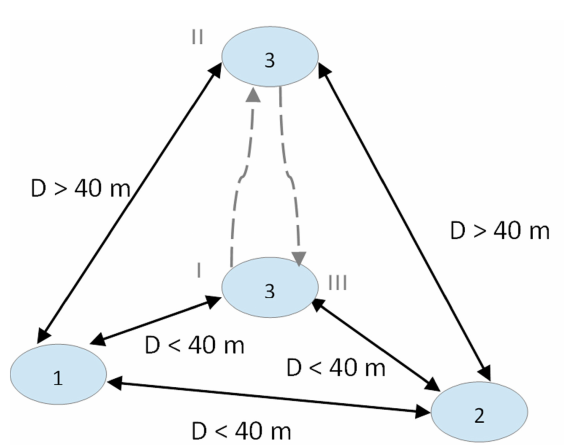
Figure 8. Dynamic test.